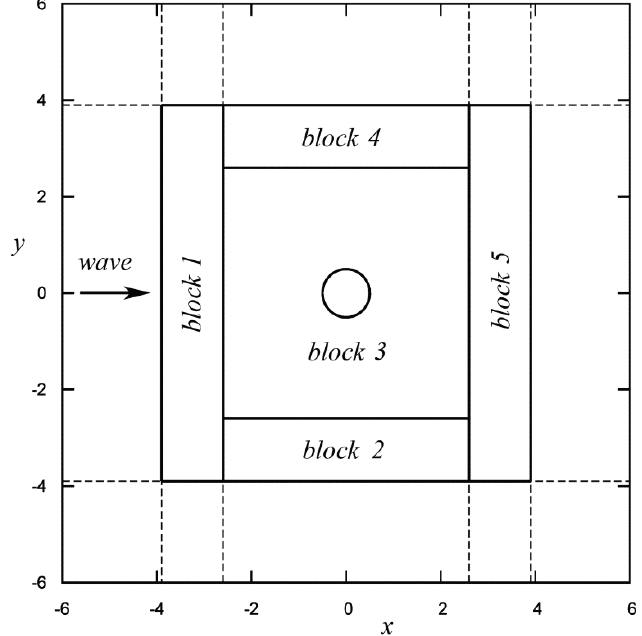
Figure 9. Subdivision of computing domain in grid-point blocks (top